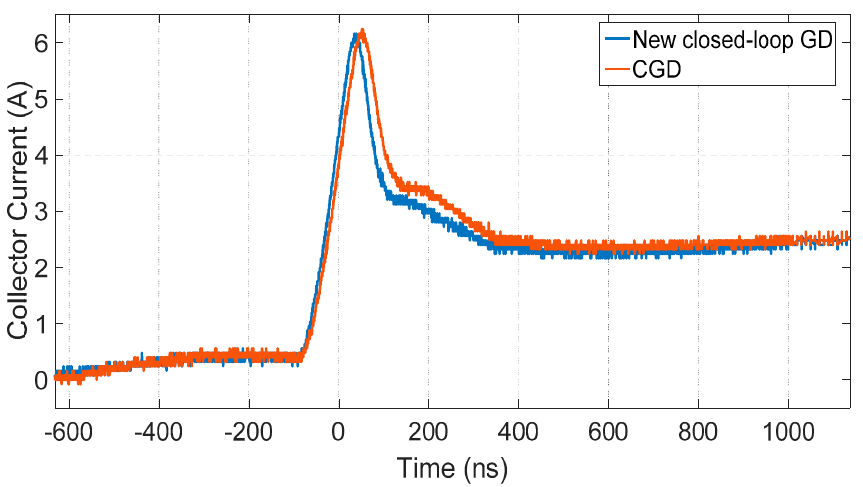
Figure 6. The resultant i C from the closed-loop GD and conventional gate drive (CGD) at turn-on condition.